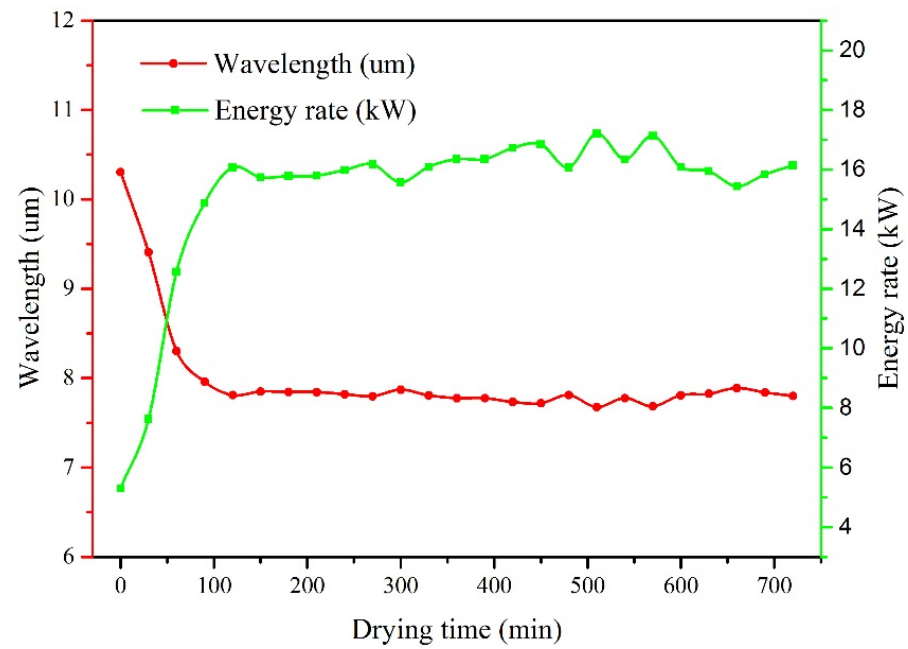
Figure 10. Variations of wavelength of the far infrared and the energy recovery process.